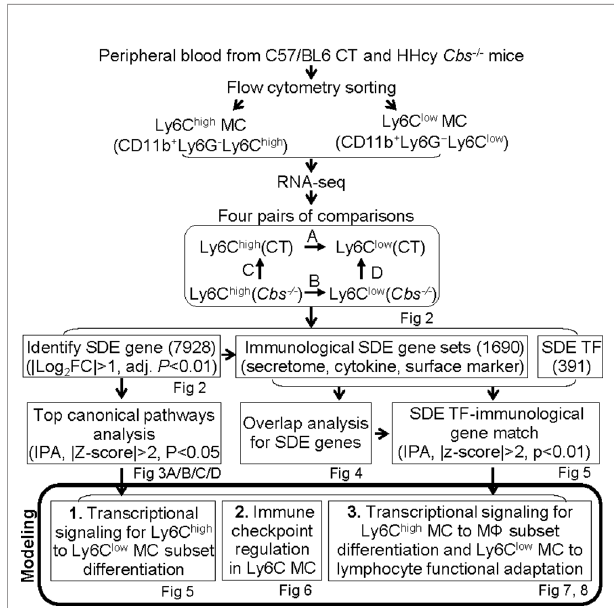
FIGURE 1 | Overall strategy of the identi fi cation of Ly6C MC regulatory genes and molecule mechanism for Ly6C monocyte subset differentiation in control and Cbs -/- mice. RNA-seq were performed in Ly6C high (CD11b + Ly6G − Ly6C high ) and Ly6C low (CD11b + Ly6G − Ly6C low ) MC isolated by fl ow cytometry sorting from peripheral blood of C57/BL6 control and Cbs -/- mice. Transcriptome data were analyzed by performing four pairs of comparisons; (A) Ly6C high vs. Ly6C low (CT), (B) Ly6C high vs. Ly6C low ( Cbs -/-